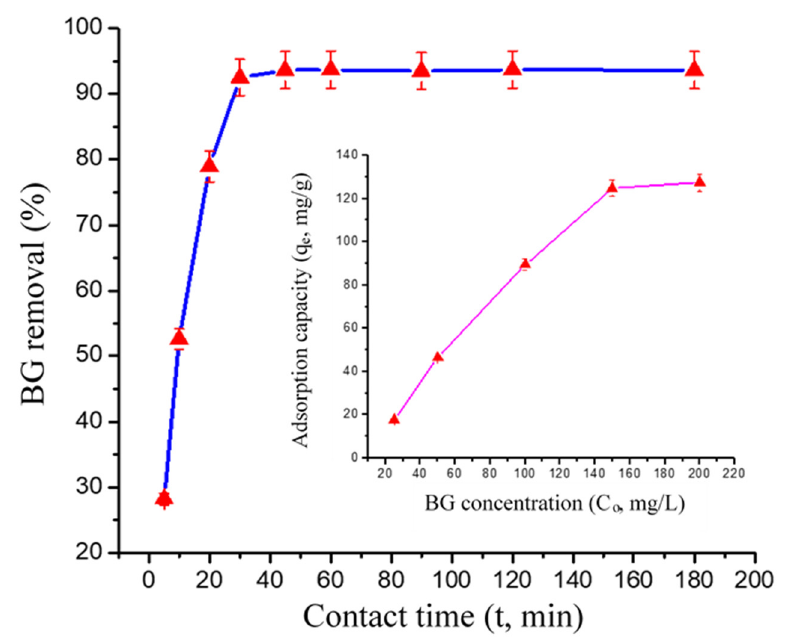
Figure 4. Brilliant green (BG) adsorption mechanism on GO-PANI.